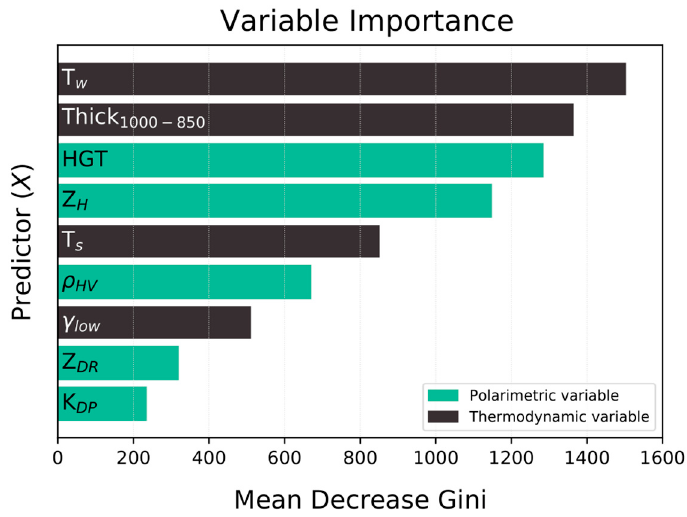
Figure 3. The importance of the predictors (mean decrease Gini) with importance decreasing from top to bottom. Polarimetric variables are in green and thermodynamic variables are in gray.